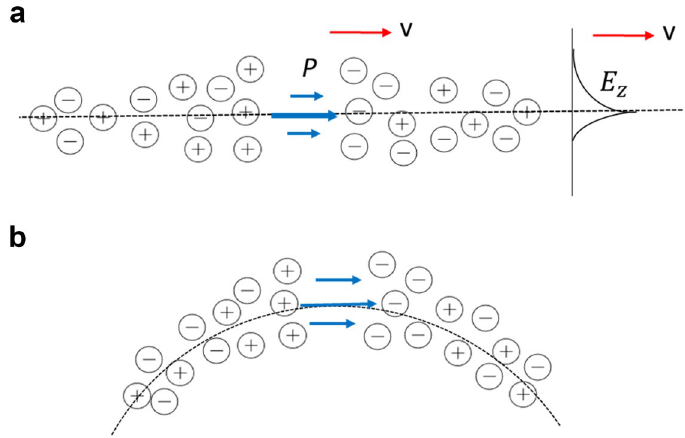
Figure 2. Simplified representation of the motion of a polarized region. The velocity v coincides with the velocity of the surface electromagnetic field. In ( a ) on the right, the exponential dependence of the electromagnetic field intensity on the distance away from the interface is shown; ( b ) the channel curvature introduces centripetal acceleration of the moving polarized region and electrons.